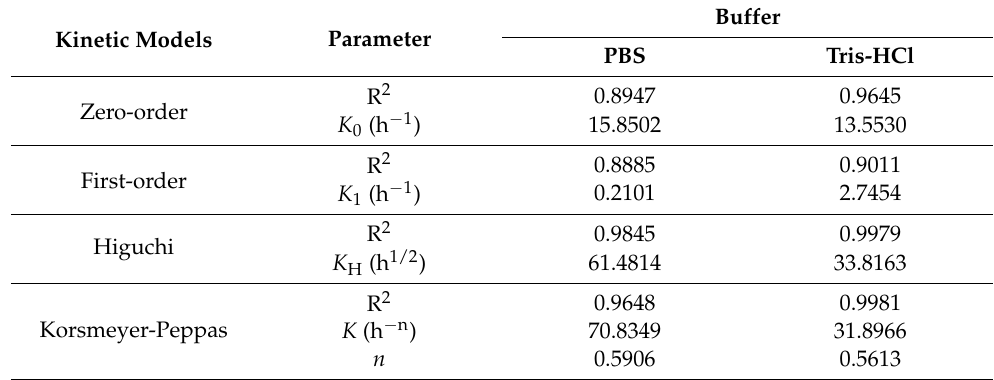
Table 5. BC/A-PHMB released kinetic profile in various drug release models.